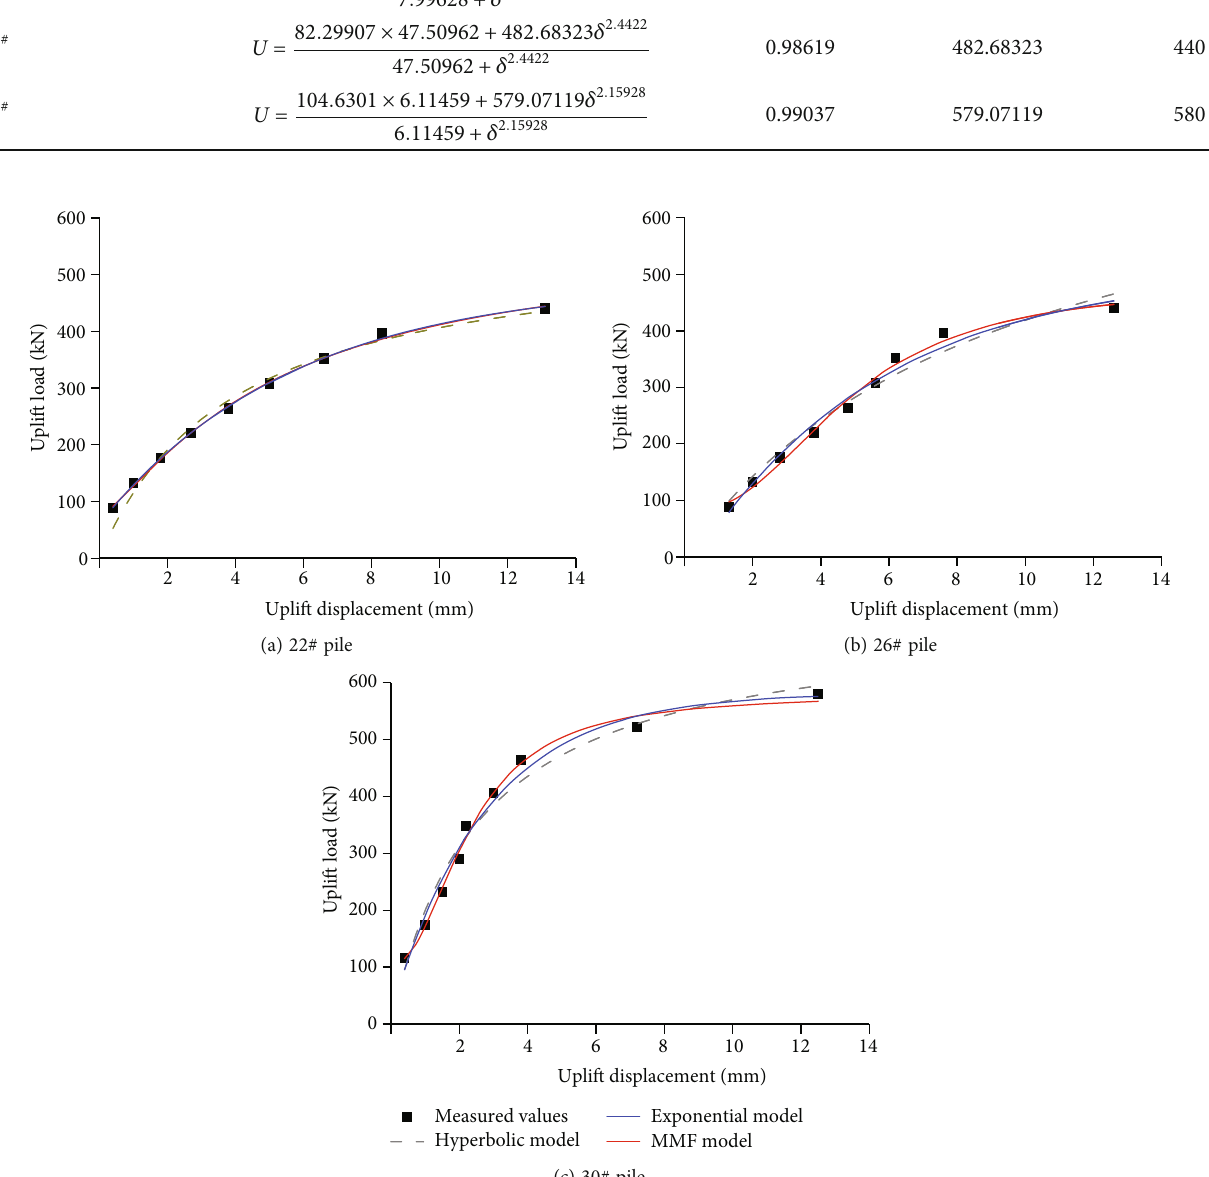
Figure 8: Comparison of MMF model with hyperbolic model and exponential model.